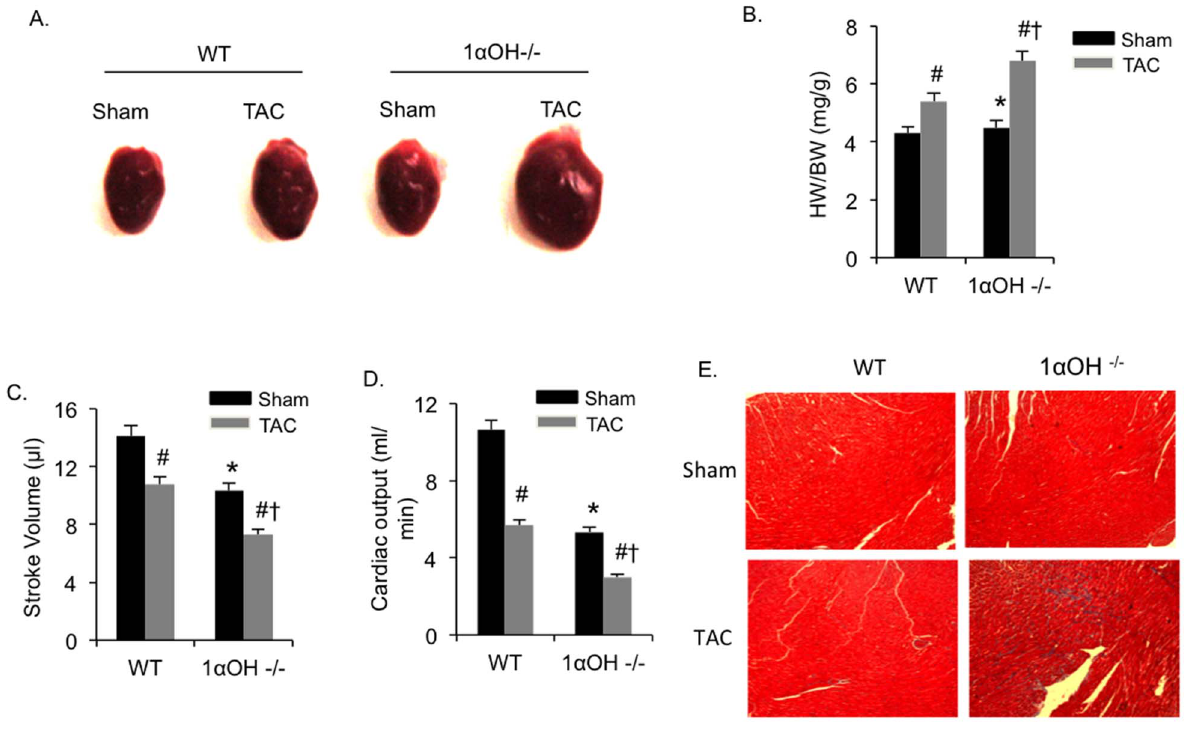
Figure 2. In response to pressure overload mutant mice showing exaggerated hypertrophy. (A) Representative hearts after 4 weeks of sham or TAC in WT and 1 a -OHase 2 / 2 mice. (B) HW/BW after 4 weeks of sham or TAC in WT and 1 a -OHase 2 / 2 mice. *, p , 0.05 compared to WT. # , p , 0.05 compared to sham. { , p , 0.05 compared to WT TAC. N=8–10. (C and D) Stroke volume (C) and cardiac output (D) in WT and 1 a -OHase 2 / 2 mice after 4 weeks of sham or TAC. *, p , 0.05 compared to WT. # , p , 0.05 compared to sham. { , p , 0.05 compared to WT TAC. N=8–10. (E) Representative Masson-Trichrome heart staining in 1 a -OHase 2 / 2 mice after 4 weeks of sham or TAC.